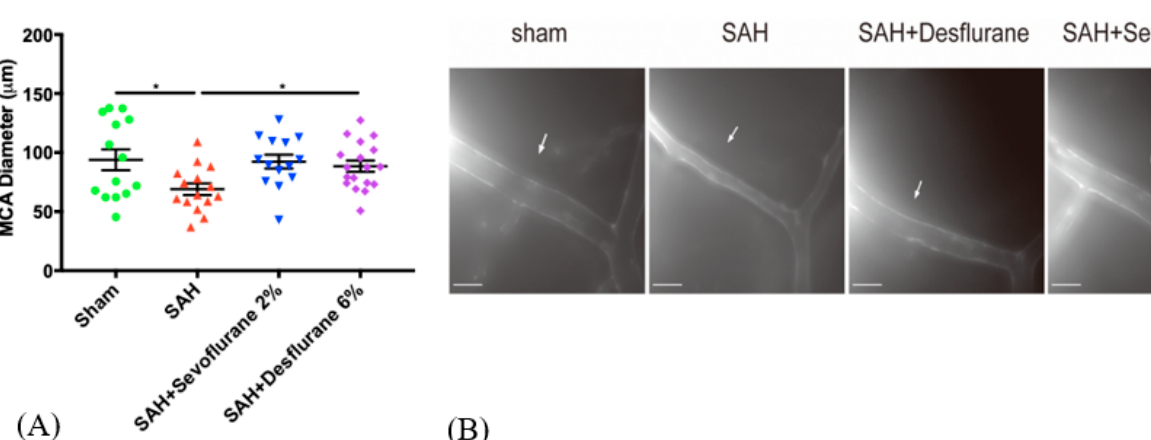
Figure 2. Sevoflurane and desflurane conditioning attenuates SAH-induced vasospasm: Mice were exposed to 2% sevoflu- rane, 6% desflurane, or room air for one hour, one hour after the SAH or sham surgery. ( A ) Imaging of the L-MCA diameters were performed on day 3. Data are presented as mean ± SEM. A one-way ANOVA and post hoc Student–Newman–Keuls test were used to compare groups: Sham vs. SAH + room air * ( p < 0.05), SAH + room air vs. SAH + Sevoflurane * ( p < 0.05), SAH + room air vs. SAH + Desflurane * ( p < 0.05). ( B ) Representative images of L-MCA. Arrow marks indicate the L-MCA vessel. Scale corresponds to 500 µ M.